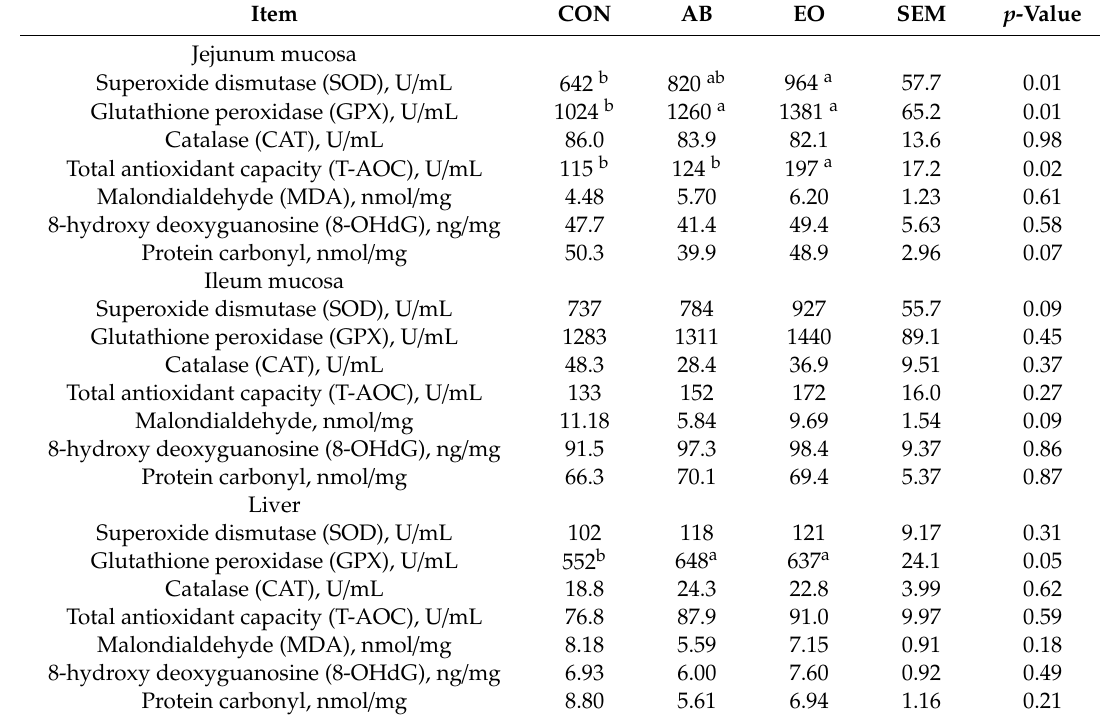
Table 7. E ff ects of essential oil supplementation on antioxidant enzyme activity and oxidant products of intestine mucosa and liver in weaned piglets 1